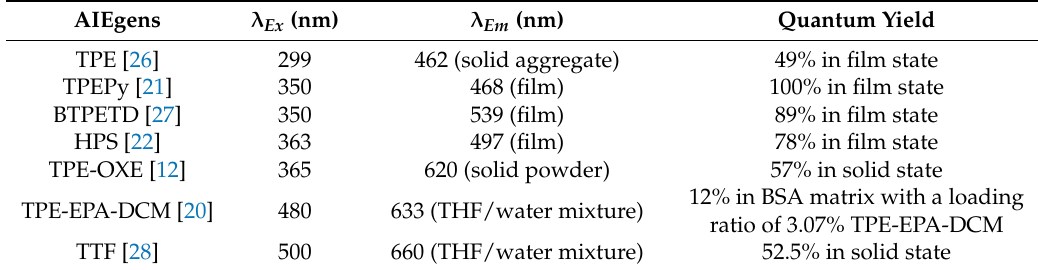
Table 1. Optical properties of typical